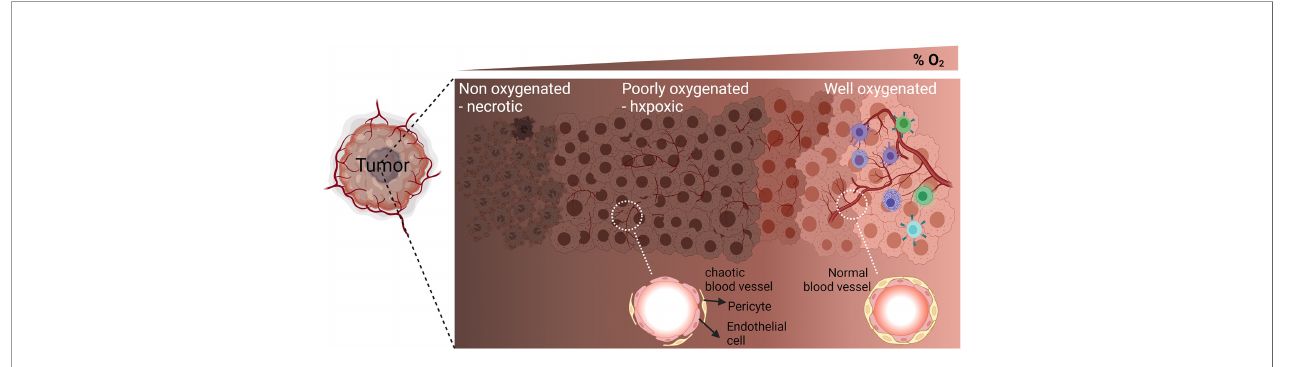
FIGURE 1 | Graphic representation of the different areas in the tumor microenvironment according to the oxygenation level (percent of O 2 ): Well oxygenated, poorly oxygenated, and non-oxygenated or necrotic areas. Enlargement of a blood vessel section in the poorly oxygenated hypoxic area shows defect in the organization of endothelial cells and pericytes ’ coverage. Enlargement of a blood vessel section in the well oxygenated area shows well-structured endothelial cells and pericytes ’